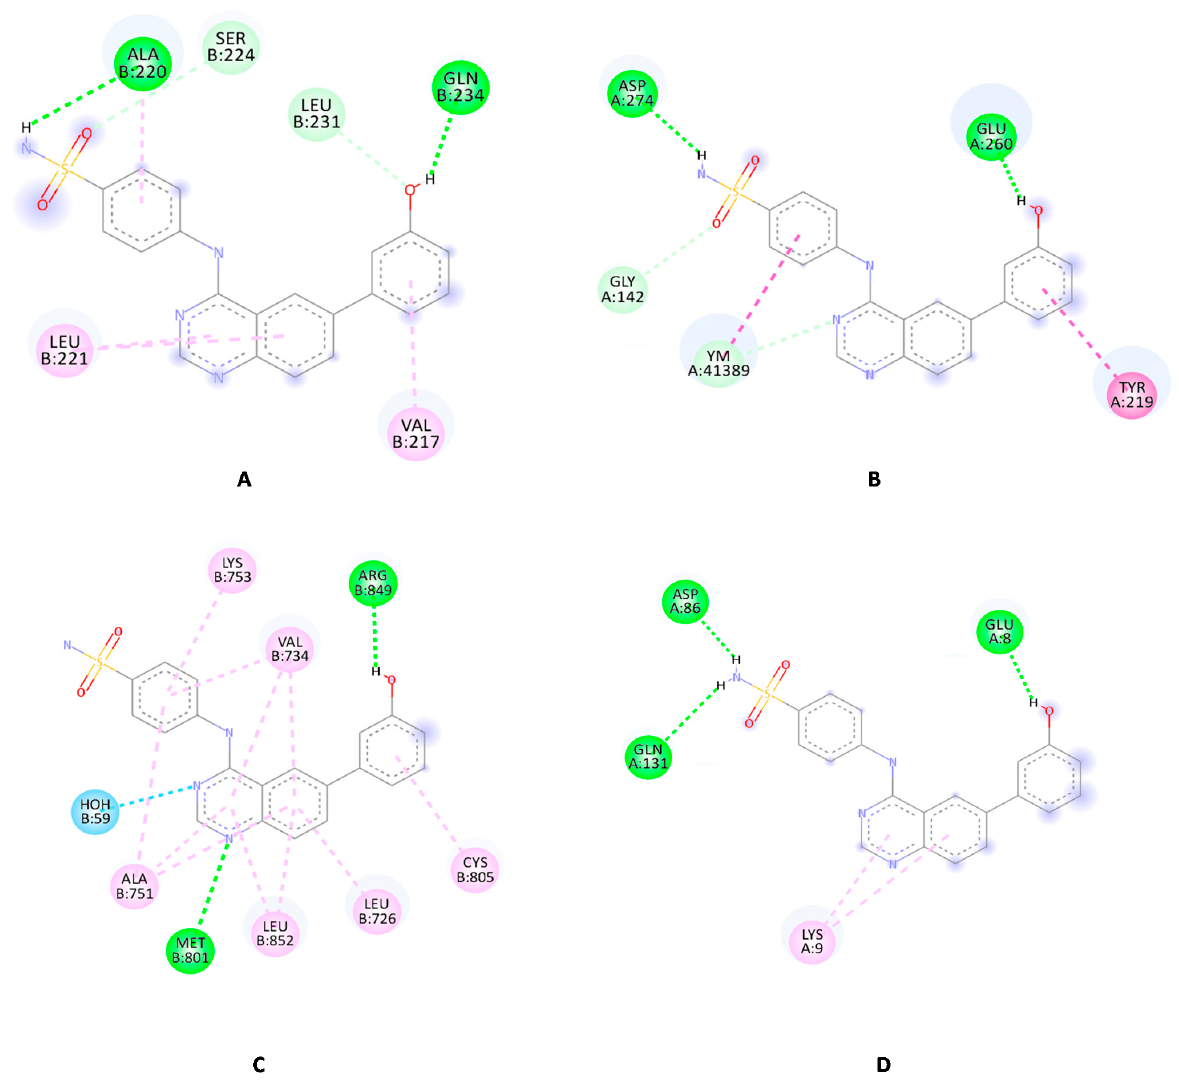
Figure 9. The 2D interaction pattern of compound 4c in the binding sites of Aurora A ( A ), VEGFR2 ( B ), HER2 ( C ) and CDK2 ( D ). Favorable interactions are color coded as follows: green, hydrogen bonds; dark pink, π – π stacking interactions; purple, π –sigma interactions; light green, unconventional carbon–hydrogen bonds.